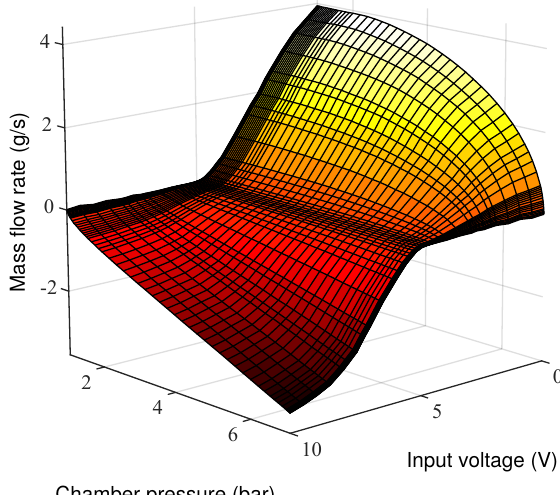
Figure 1. Servo-valve relation between input voltage, actuator chamber pressure and mass flow rate of the air entering the